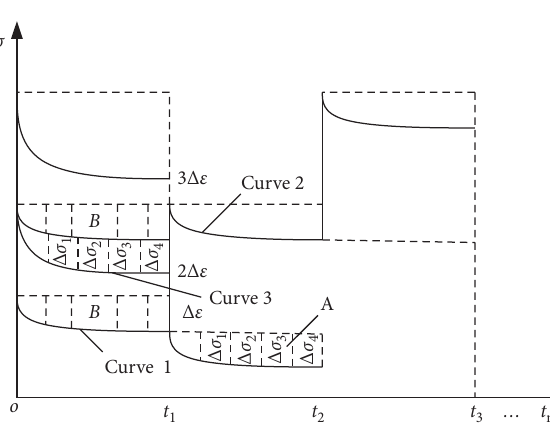
Figure 6: Processing methods of relaxation